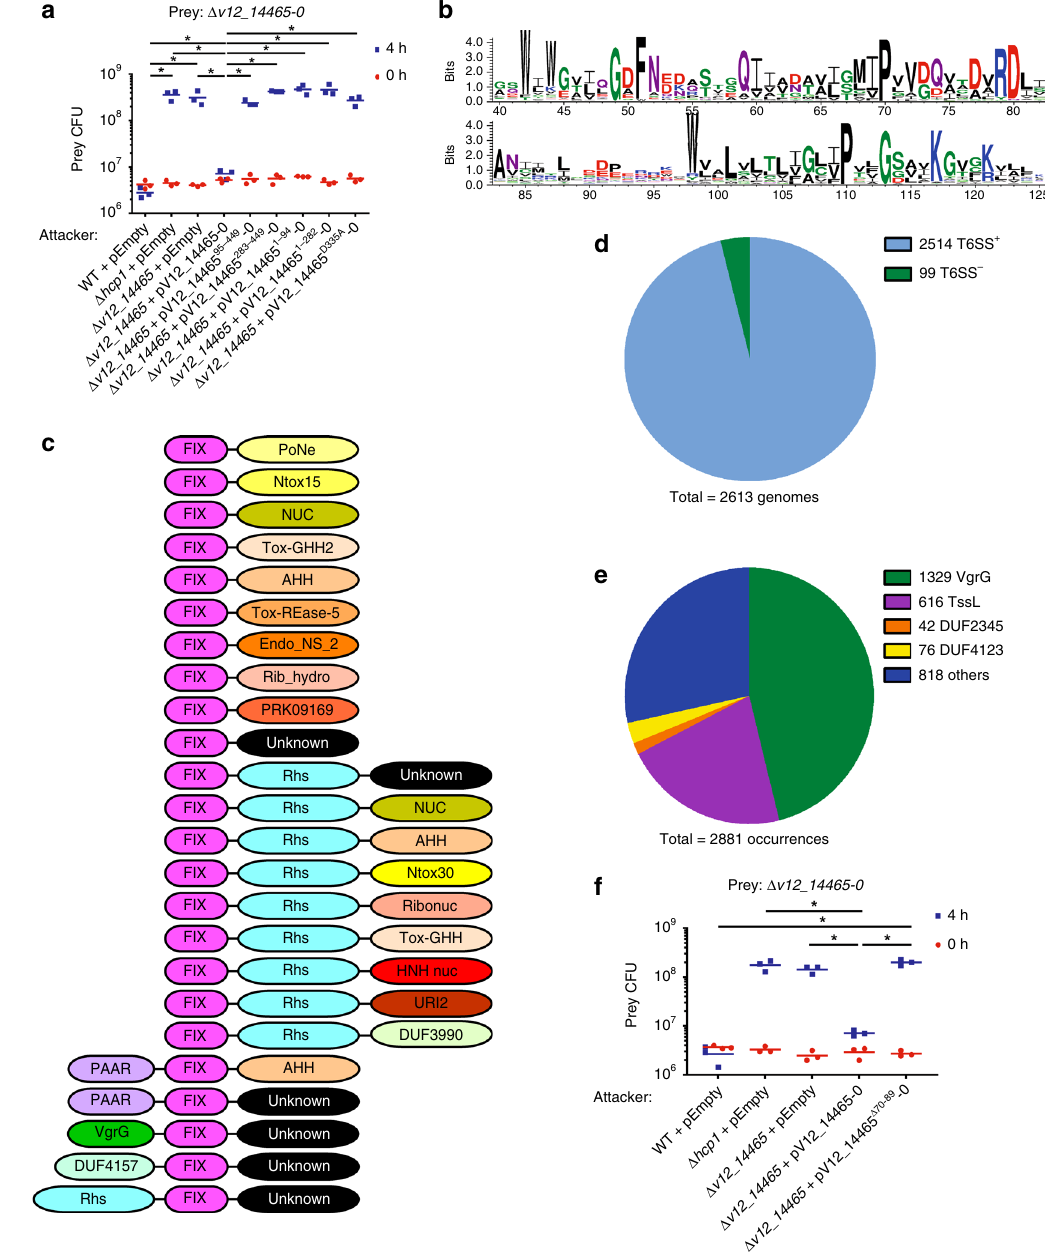
Fig. 4 V12_14465 contains a marker for T6SS substrates. a Viability counts of V. parahaemolyticus 12-297/B prey before (0 h) and after (4 h) co-incubation with the indicated V. parahaemolyticus 12-297/B attackers at 30 °C on media containing 3% NaCl. b Conservation pattern found in FIX homologs. The region shown corresponds to positions 40 – 125 in V12_14465. The image was produced using WebLogo 3. c Representative domain architectures of FIX- containing proteins. d Pie chart of FIX-containing bacterial genomes that encode a T6SS (encoding at least 9 T6SS core components). e Pie chart of domains encoded by genes found immediately upstream of FIX. The number of occurrences for each domain is listed next to its name. f Viability counts of V. parahaemolyticus 12-297/B prey before (0 h) and after (4 h) co-incubation with the indicated V. parahaemolyticus 12-297/B attackers at 30 °C on media containing 3% NaCl. Asterisks denote the statistical signi fi cance between samples at the 4 h timepoint by unpaired, two-tailed Student ’ s t test (* P < 0.05); WT wild-type. Source data are provided as a source data fi